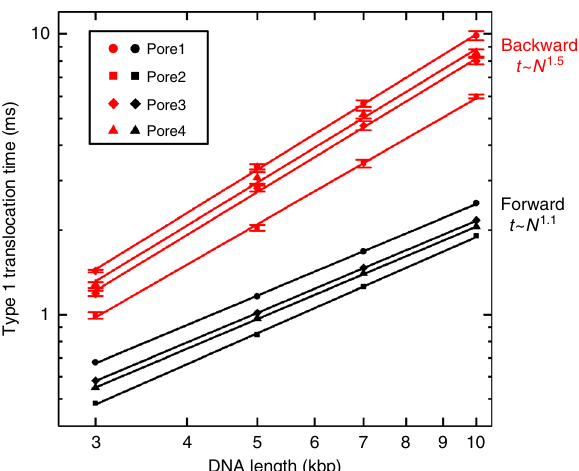
Fig. 3 Type 1 translocation time as a function of DNA length. Data show mean value, error bars in the backward direction are the standard error of the mean ( error bars are smaller than symbol sizes in forward direction). Each data set shows a least squares linear fi t to the data. The average scaling exponent of the four pores is